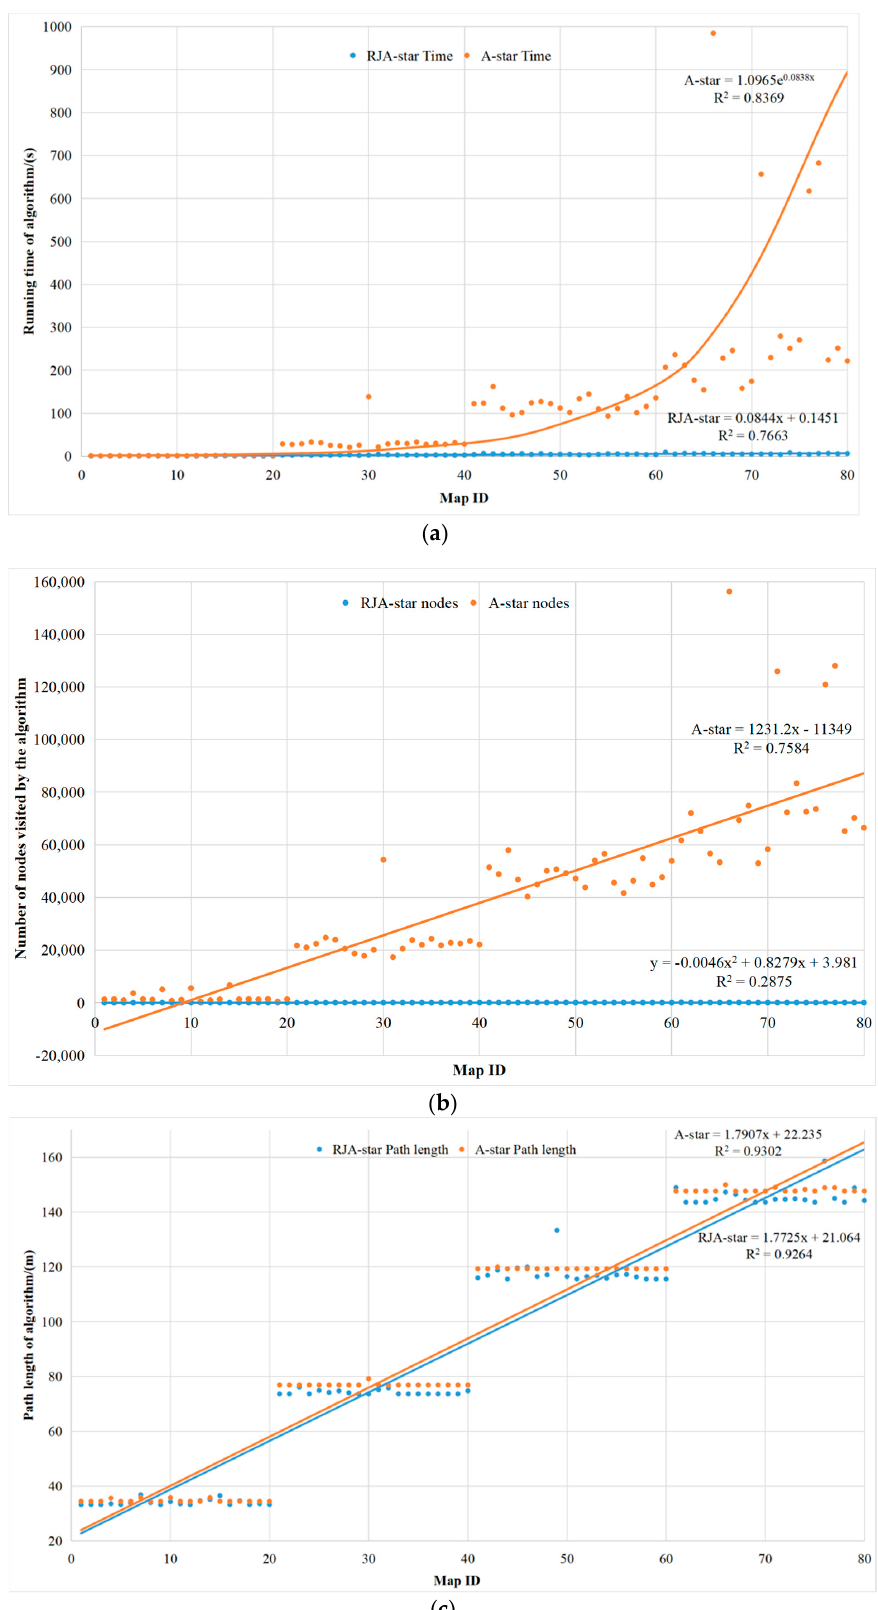
data. As shown in Figure 12a–c.